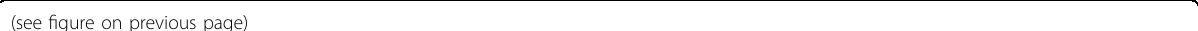
Fig. 2 DNA binds to CCAN through the CENP-LN channel. a The 3.7 Å resolution cryo-EM density map of CCAN – DNA complex at two different views. The density map of DNA is colored by hotpink and the others are shown in gray transparent surfaces. b Electrostatic potential surface view of CENP-LN-HIK head -TW binding with DNA. The DNA is shown as cartoon. Note that positively charged amino acids from CENP-LN, CENP-I and CENP-TW constitute the contact sites between CCAN and DNA. c , d Comparison of elution pro fi les ( c ) of CCAN Δ CT -CENP-A 167 /CCAN Δ CT -CENP-A 167-(R80A-G81A) and CCAN 6E- Δ CT -CENP-A 167 in Superose 6 5/150 GL (GE Health) and the Coomassie-blue stained 15% SDS-PAGE gel. CENP-A 167 is the CENP-A nucleosome reconstituted by using a DNA fragment of 167 bp in length. d The CCAN Δ CT complex bound to either CENP-A nucleosome or CENP- A R80A-G81A nucleosome which reconstituted with 167 bp DNA, but the CCAN 6E- Δ CT complex failed. The CCAN Δ CT complex includes CENP-LN, CENP- HIKM and CENP-OPQUR, but not CENP-C and CENP-TWSX; the CCAN 6E- Δ CT complex includes charge mutations of positively-charged residues on the CENP-LN (K270E/K296E in CENP-N 2E , K155E/R306E/K319E/K321E in CENP-L 4E ) in contact with DNA; two degradation products of CENP-R annotated as CENP-R Δ 1 and CENP-R Δ 2 in gray color. Of note, the two separated peaks seen in the elution represent wild type CCAN (red line) and CENP- A Nuc – binding de fi cient CCAN (green line) complex with CENP-A Nuc and CENP-A Nuc which are indistinguishable. However, DNA binding-de fi cient CCAN (cyan line) failed to bind nucleosomal DNA, validating that CCAN binds to DNA via CENP-LN. See also Supplementary Figs. S5,